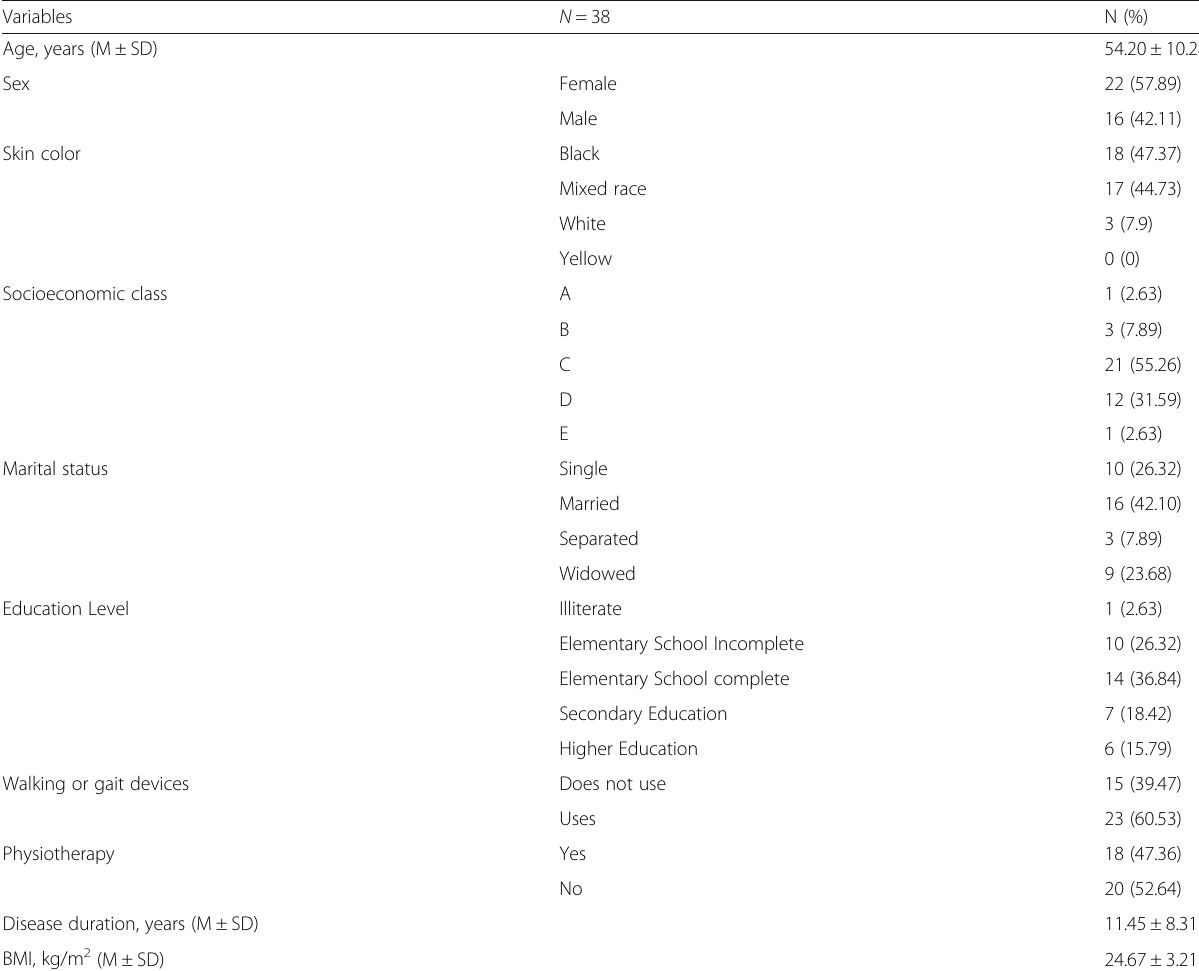
Table 1 Sociodemographic and clinical characteristics of individuals with HAM/TSP of the CTHTLV of the Bahiana School of Medicine and Public Health, Salvador, Bahia,